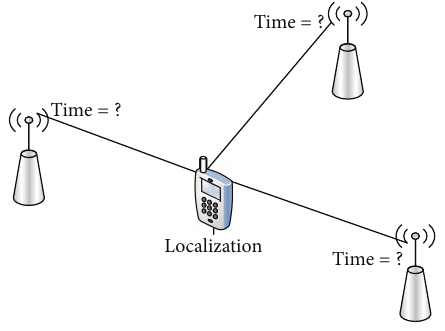
Figure 6: Time difference of arrival (source